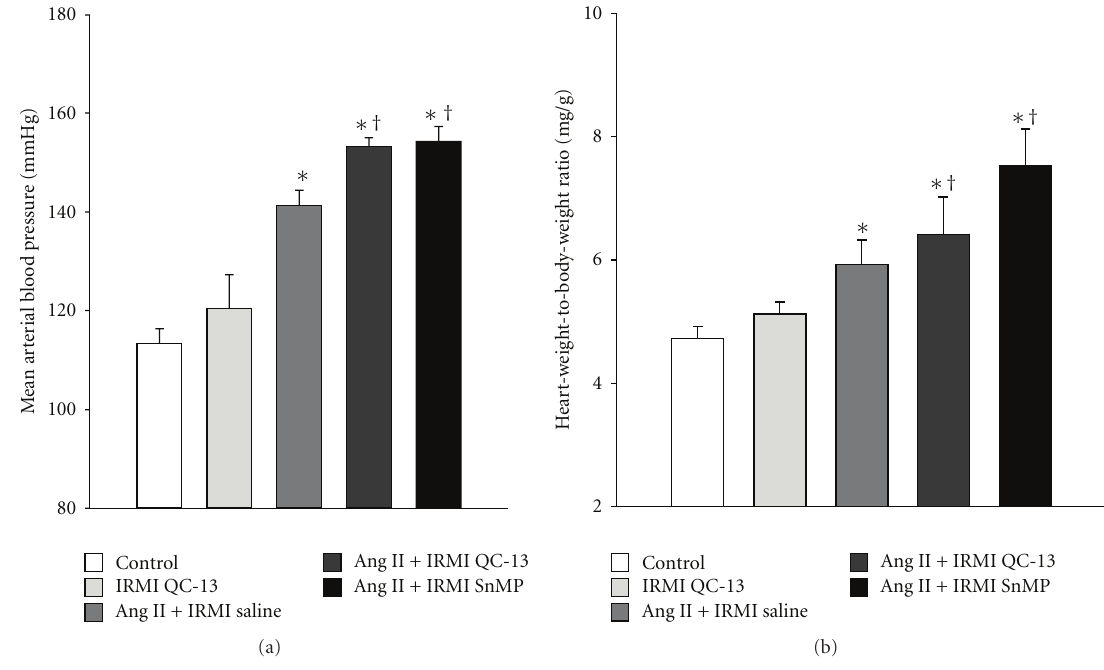
Figure 1: Mean arterial blood pressure (a) and cardiac mass index (b) in control, IRMI QC-13, Ang II + IRMI saline, Ang II + IRMI QC-13, and Ang II + IRMI SnMP-treated mice, n = 6/group. ∗ P < 0 . 05 as compared to value in control mice. † P < 0 . 05 as compared to Ang II-treated mice. IRMI, intrarenal medullary interstitial